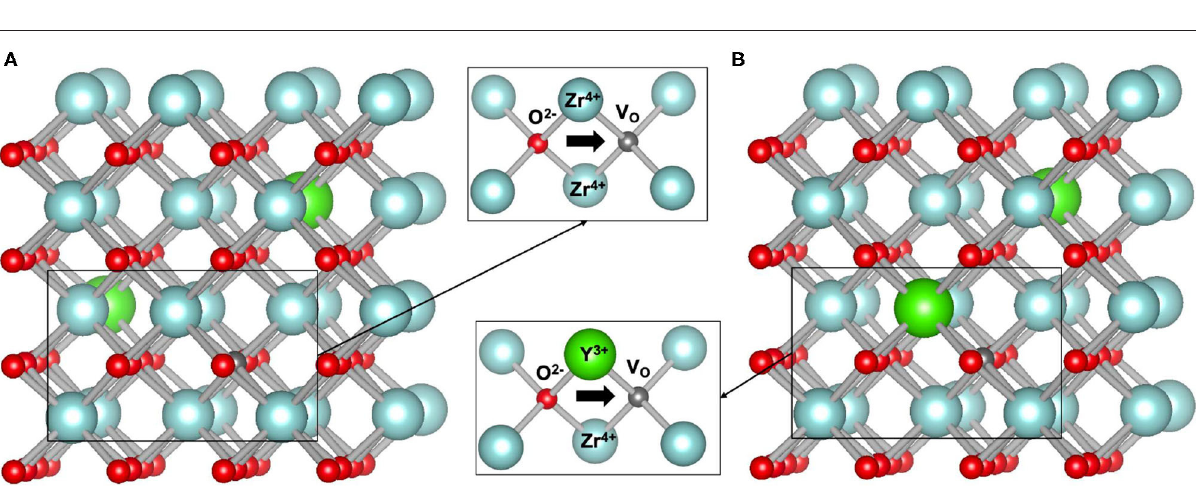
FIGURE 3 | The mixing free energy for Li x FePO 4 solid solution computed at room temperature, T , as G E = [ W 1 (1 − x ) + W 2 x ] x (1 − x ) + RT [ x ln x + (1 − x )ln(1 − x )] (Li et al., 2014), assuming configurational entropy of ideal mixing and neglecting other entropy contributions. R is the gas constant. W 1 and W 2 Margules interaction parameters are these from last column of Table 5 . The miscibility and spinodal gaps are indicated by minima and inflection points marked with blue circles.